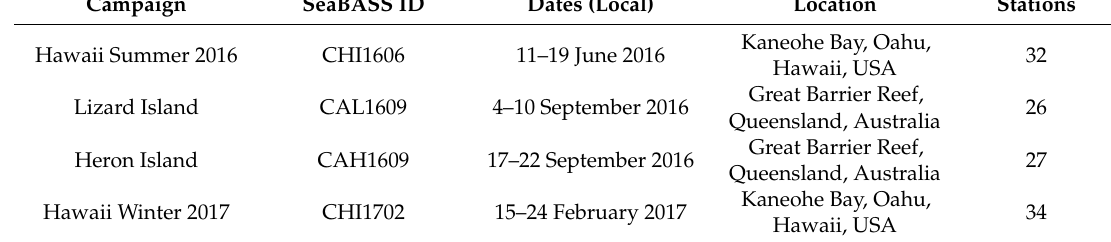
Table 2. Locations and dates of the field campaigns and the number of high quality stations sampled.